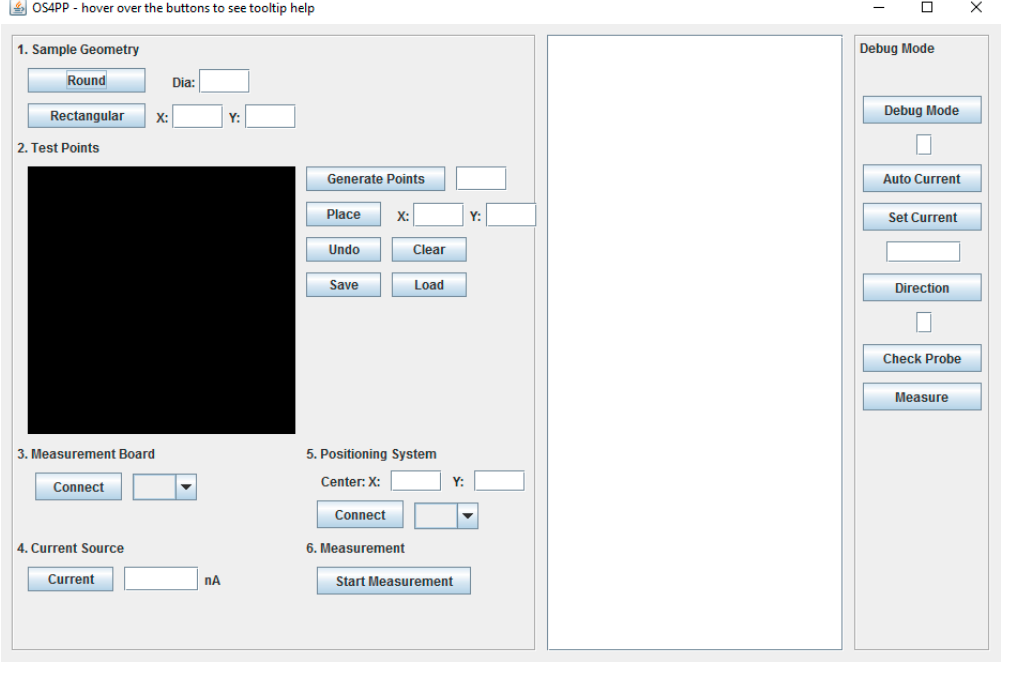
Figure 10. Discrete resistor measurement circuit. The value of the resistors for validation are 10 M Ω , 1 M Ω , 100 K Ω , 10 K Ω , 1 K Ω , 100 Ω , and 10 Ω . Current source values are set so that sufficient voltage is generated on the resistor. The measured value using the open source four-point probe circuit is compared with the measured value by a Fluke